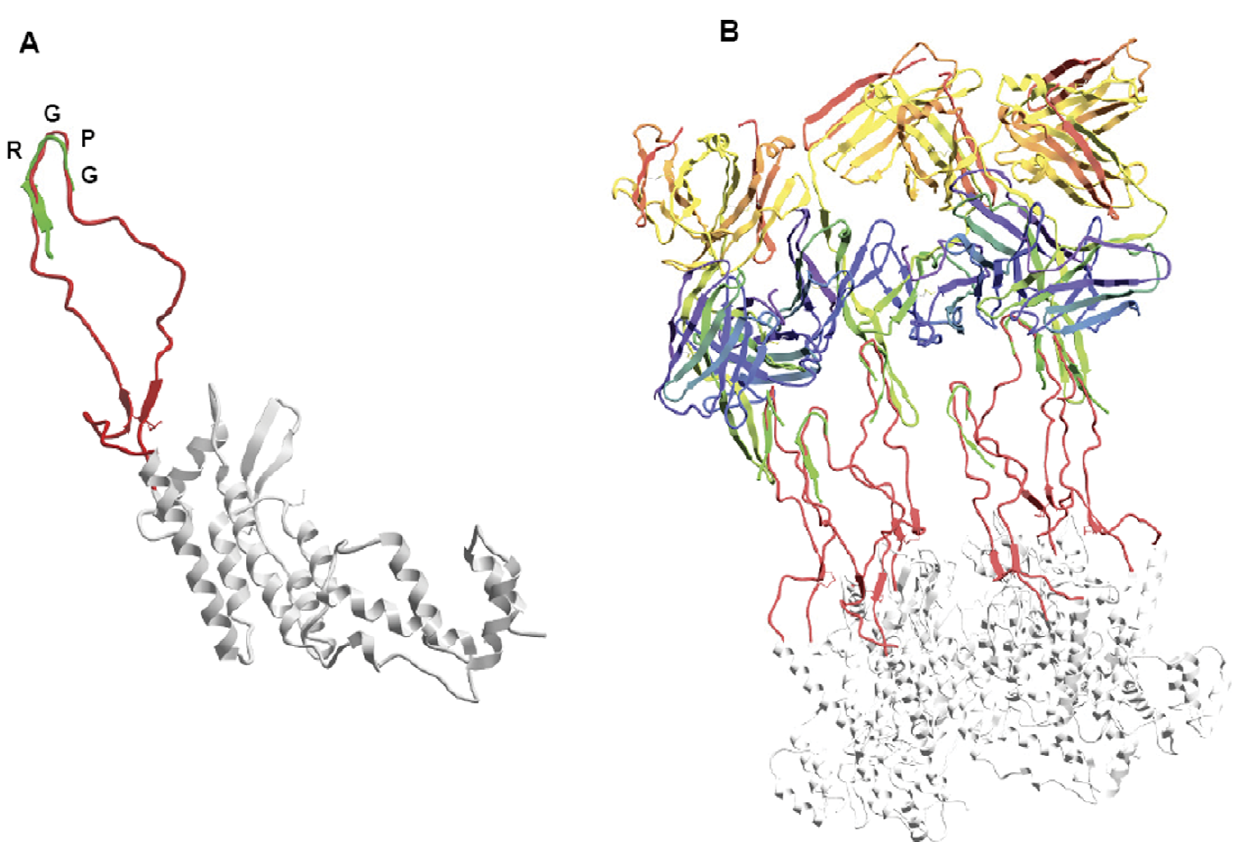
Figure 4. The engrafted V3 loop sequence is fitting to the mAb 447-52D. The engrafted V3 loop sequence (in red) is superimposed to the V3 crystallized bound to the Mab 447-52d (PDB 1Q1J) (in green) ( A ). The six engrafted V3 loop in the hexameric structure can be bound by independent mAbs. For clarity, only three out of six are indicated ( B ).